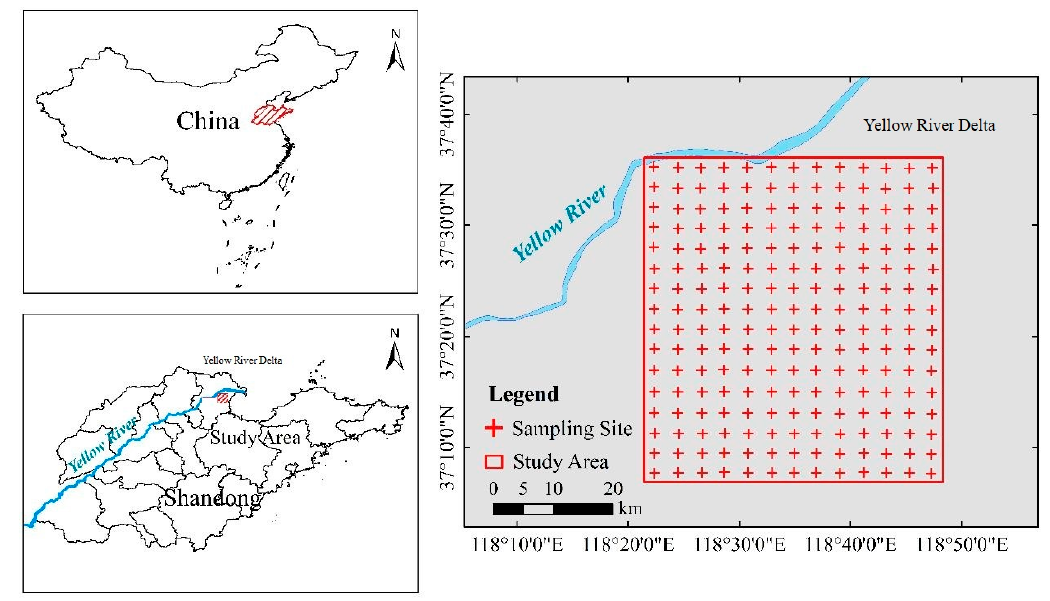
Figure 1. Location of the study area and spatial distribution of sampling sites.